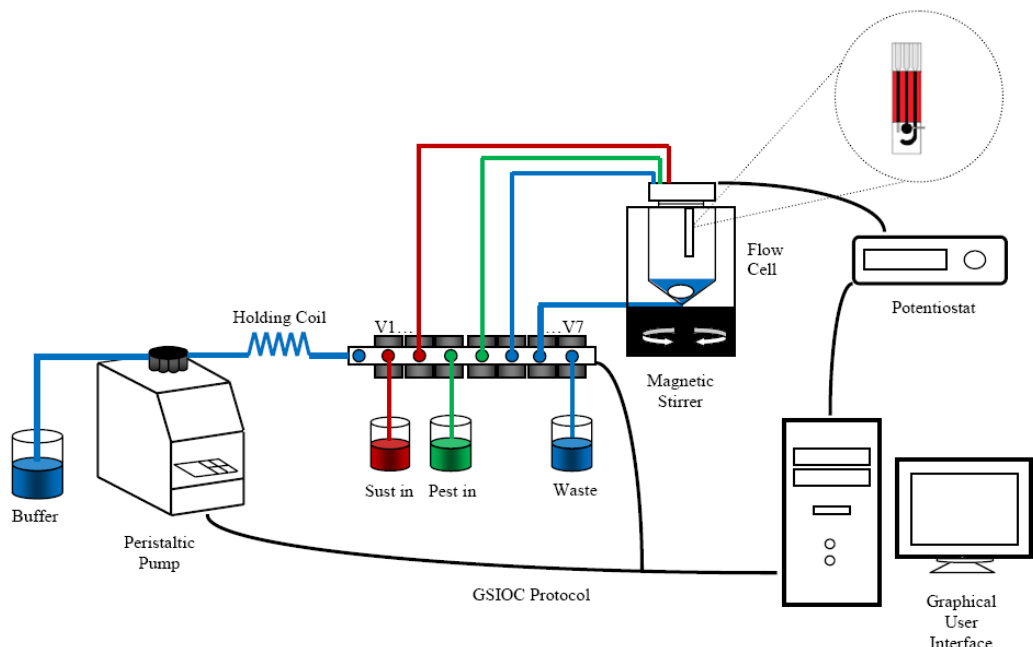
Figure 1. Manifold of the designed MCFA